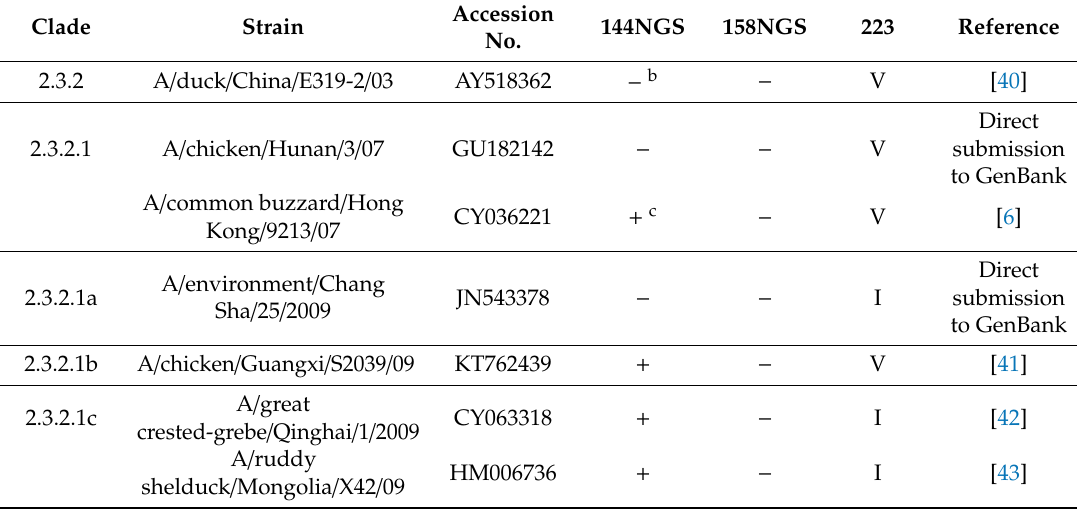
Table 2. Comparison of 144NGS, 158NGS, and the residue 223 amino acid of hemagglutinin